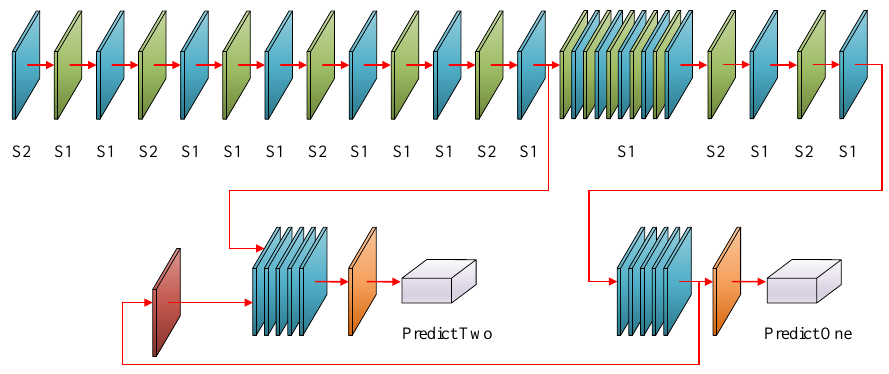
Figure 7. Structure of the YOLO-MobileNet.